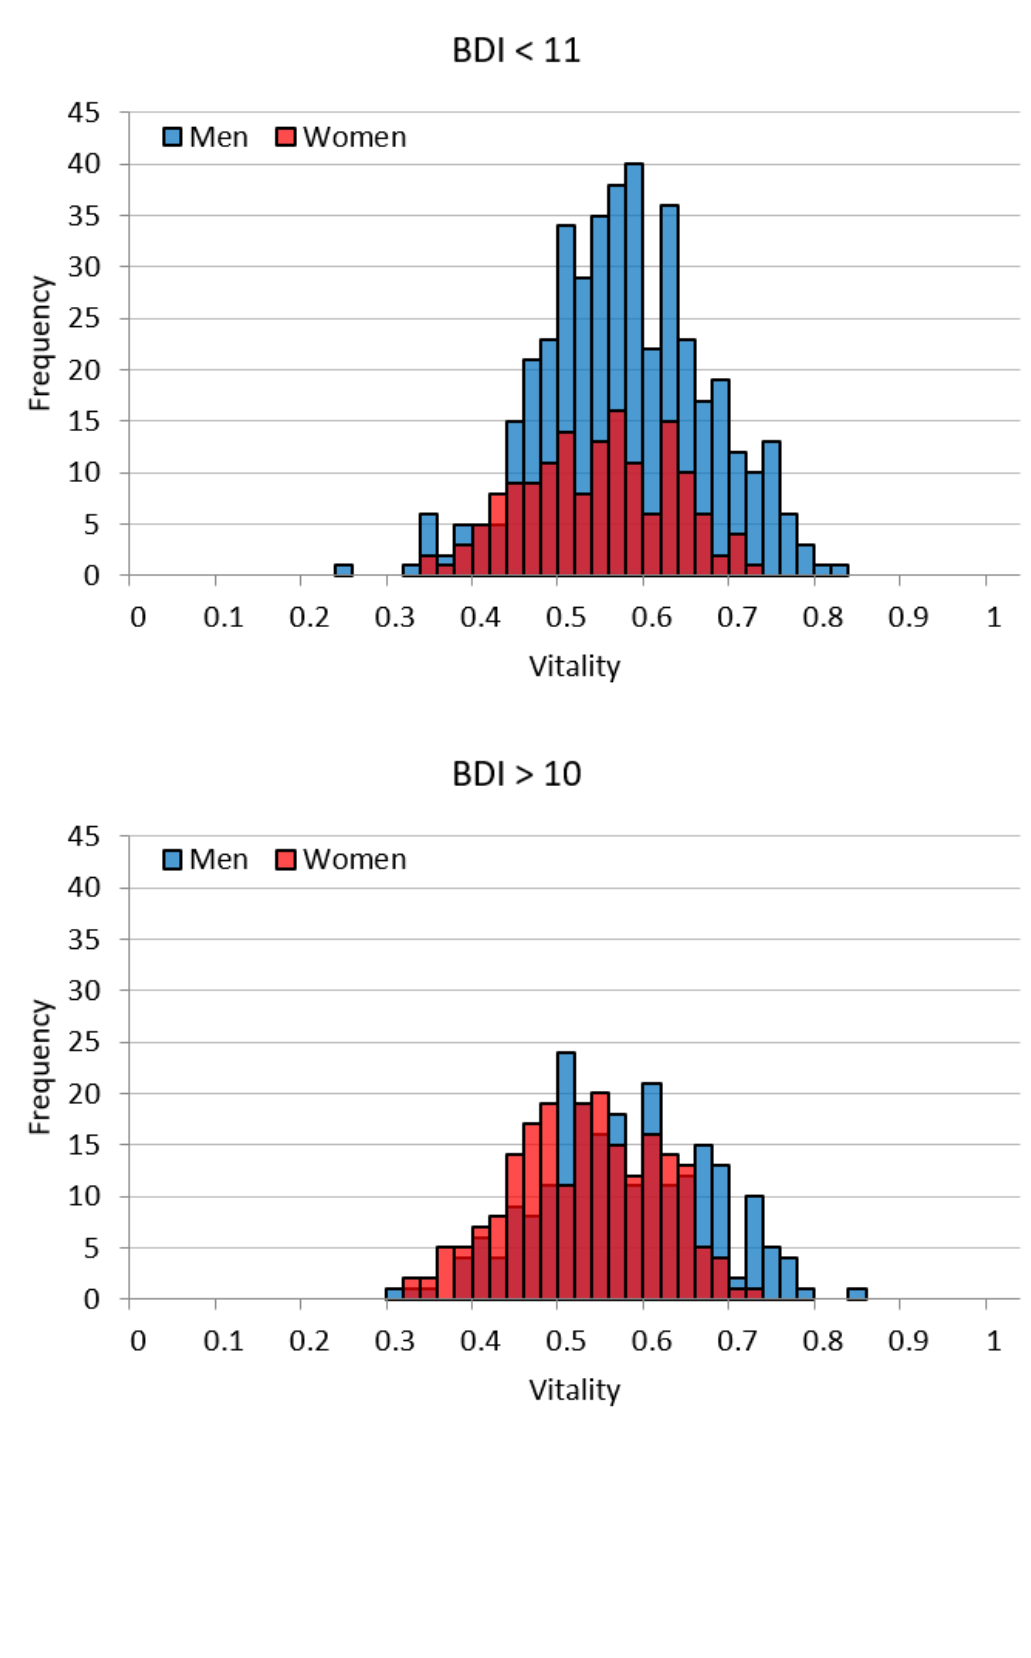
Figure 8. Vitality distribution by sex with Beck Depression Inventory (BDI) score evaluation